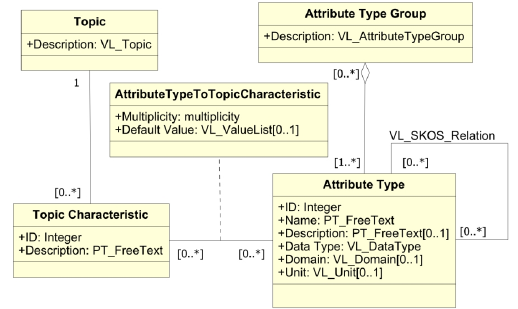
Figure 1. UML application schema of the system database